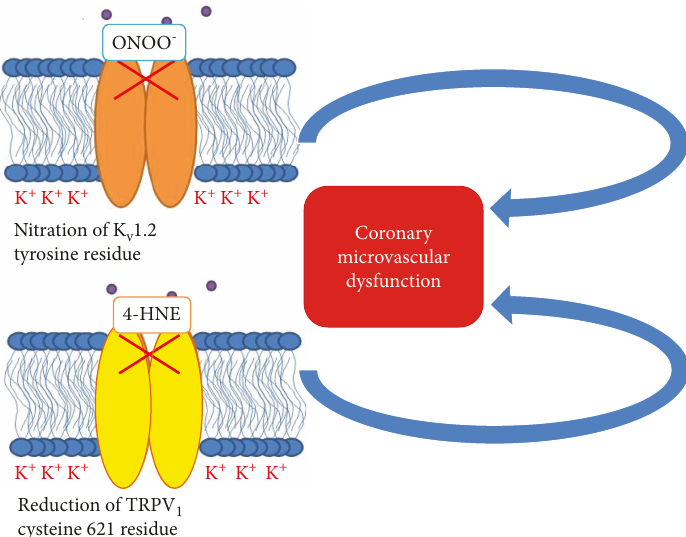
Figure 7: An excess of peroxynitrite (ONOO-) may lead to Kv-mediated vasodilatation impairment through Kv1.2 tyrosine residue nitration; 4-hydroxynonenal (4-HNE) targets a cysteine 621 residue of the TRPV1 coronary channel impairing its function and contributing to CMD in diabetes